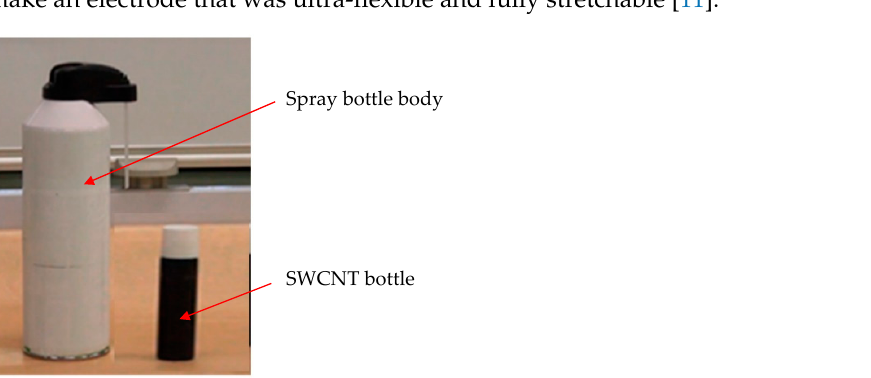
Figure 3. Spray bottle body and SWCNT bottle for spraying SWCNTs. To use the bottle containing SWCNTs on the right side, it is inserted it into the plastic tube (see arrow) of the spray body. The thickness of the electrode of the SWCNT was 70 µ . Using the above two DE car- tridges, a DEG was manufactured and used as a small power generation (DEG) device.